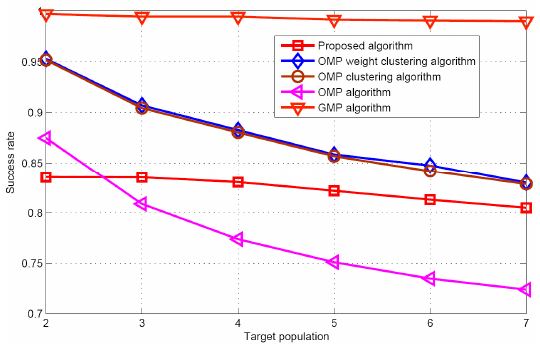
Figure 7. Success rate comparison ( D = 2.8 d).